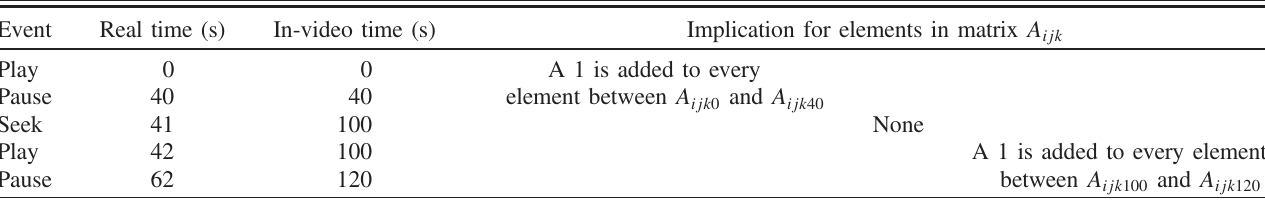
TABLE VIII. Example made-up data explaining how events would be recorded in clickstream (the first 3 columns [29]) and how matrix A ijkt would be constructed (the last 3 columns) for the following scenario: a student watched the first 40 s of a video, clicked on pause, and then clicked on the scrubber below the video to jump to the point that corresponds to 100 s in in-video time. Then, she clicked on play to continue watching the video for another 20 s. In this example, the playback rate student used was 1.